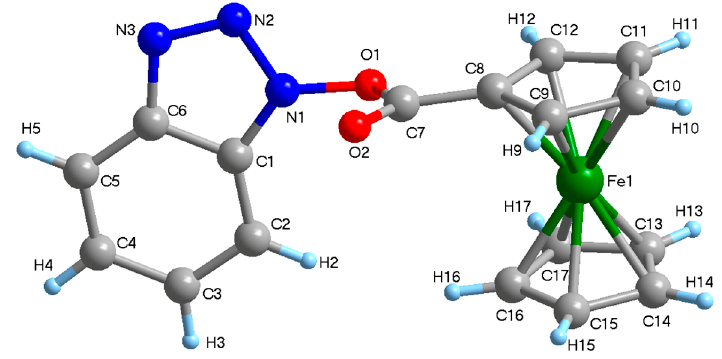
Figure 1. X-ray crystal structure of ferrocene derivative 1 .